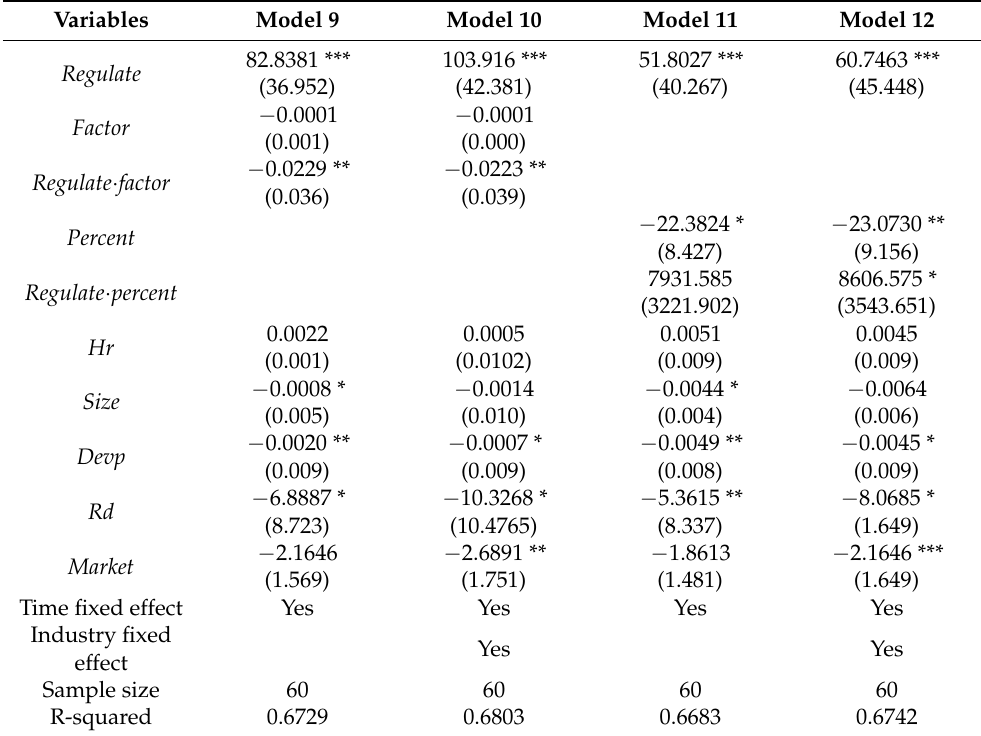
Table 5. Heterogeneity regression results from the output